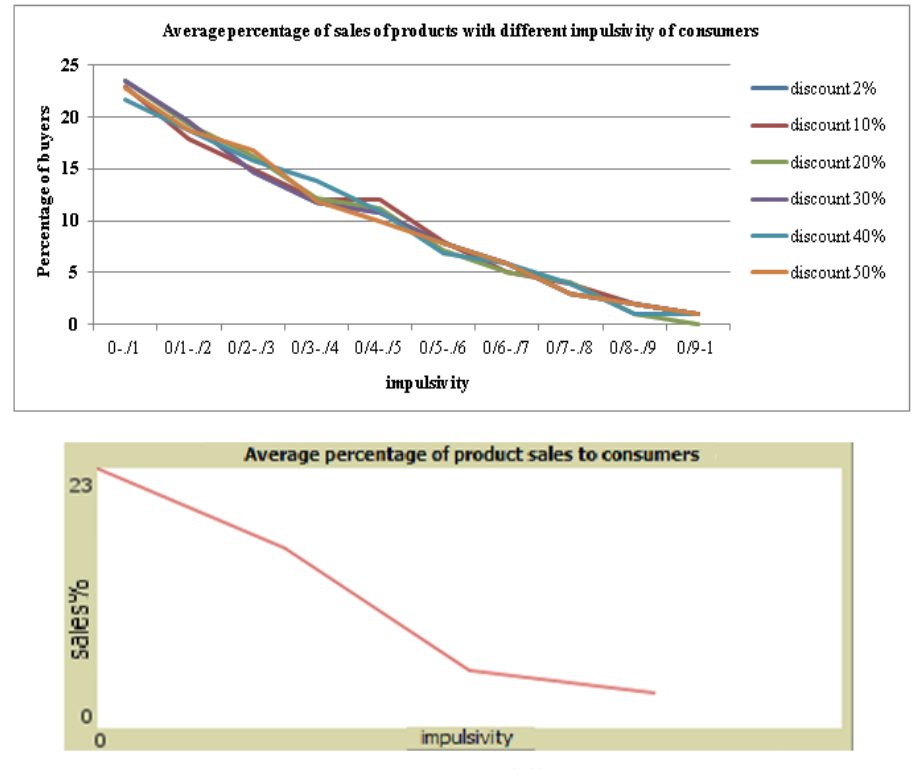
Fig. 13. Buyers with different